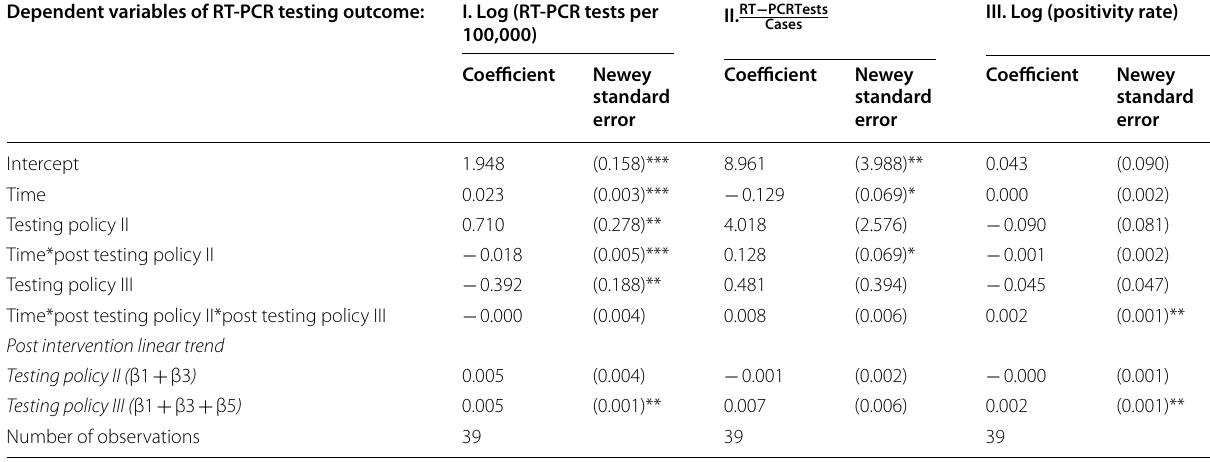
From March 29, 2020 to December 26, 2020 (aggregated data by week) For each dependent variable, the following segmented regression model was estimated: Y t Testing Policy III